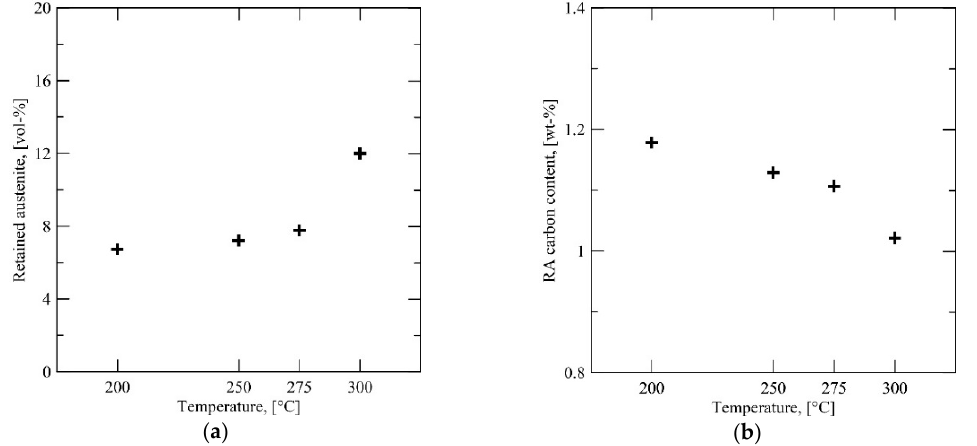
Figure 8. ( a ) The retained austenite fraction of Steel B with respect to initial quench temperature QT . ( b ) The carbon content of the retained austenite with respect to QT . Specimens annealed at 850 °C, quenched to QT and partitioned at 450 °C for 100 s.